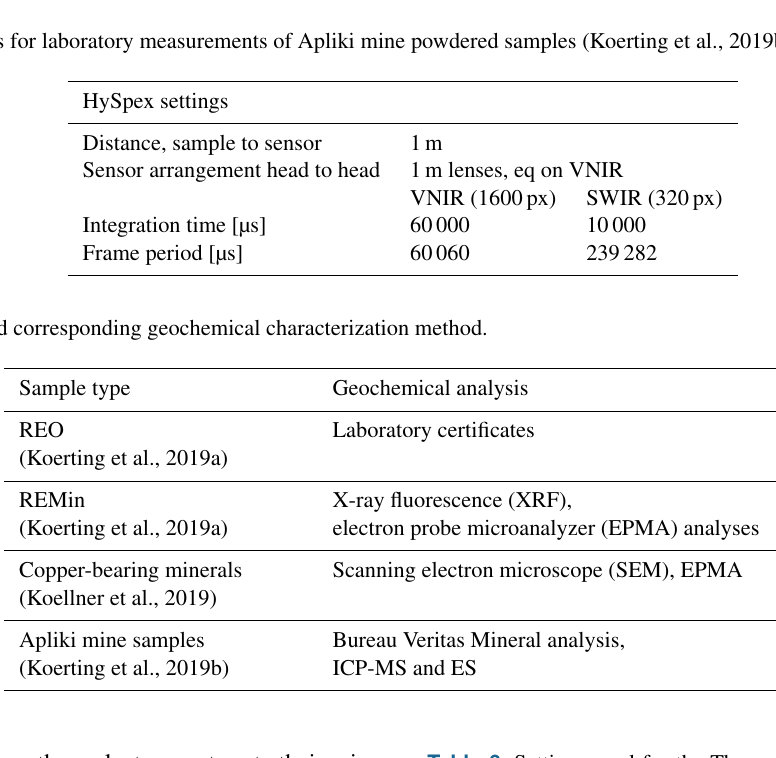
Table 6. Settings used for the Thermo Niton XL3t X-ray fluores- cence device (Bösche,